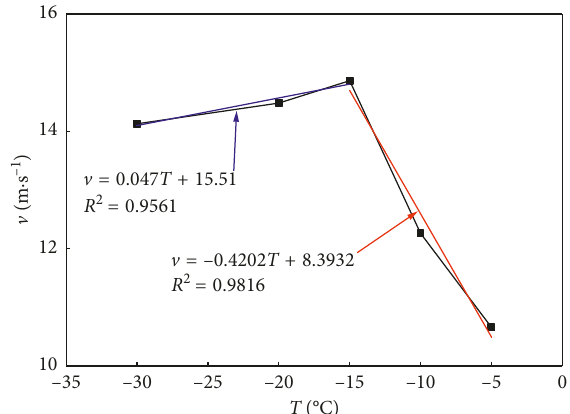
Figure 11: Relationship between the sputtering rate and temperature.